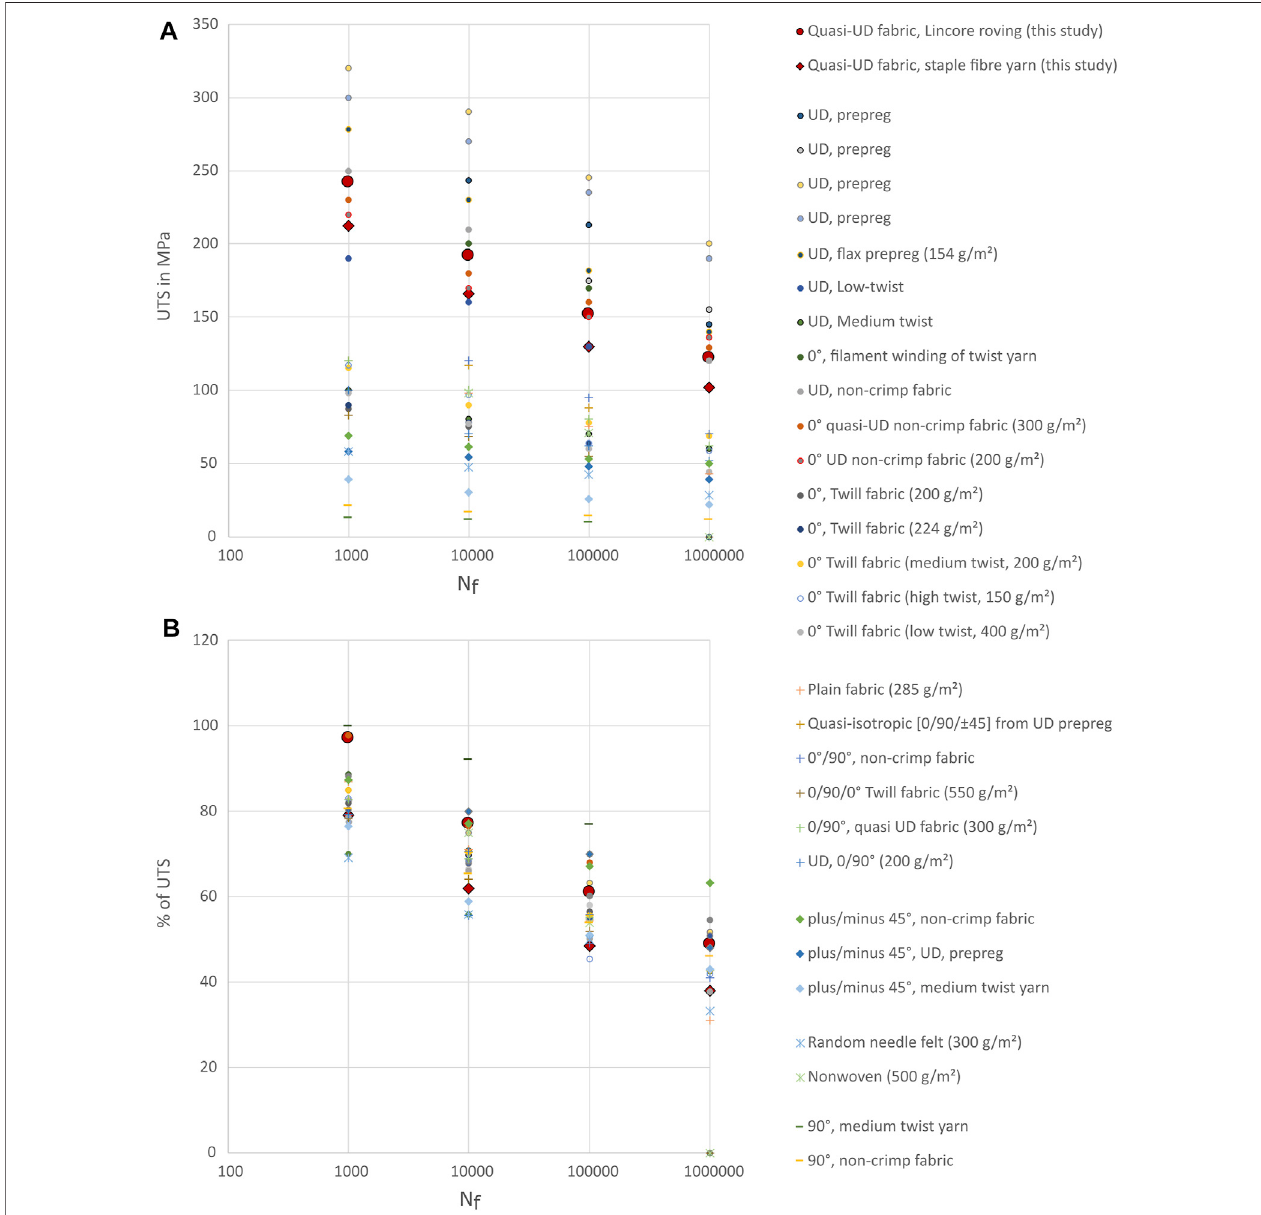
FIGURE 9 | A comparison of fl ax composites with different fi ber orientations from the literature (red circles and diamonds are the results of our test series); (A) the absolute strength is shown; (B) the relative strength in relation to the static strength is presented. The absolute values show a considerable difference between UD and differently oriented fi bers. The data were summarized from (Liang et al., 2012; Shah et al., 2013; El Sawi et al., 2014; Liang et al., 2014; Asgarinia et al., 2015; Ueki et al., 2015; Bensadoun, 2016; Bensadoun et al., 2016; Berges et al., 2016; Sodoke et al., 2016; Habibi et al., 2019; Jeannin et al., 2019; Ameur et al., 2020; Hallak Panzera et al., 2020) in a revised